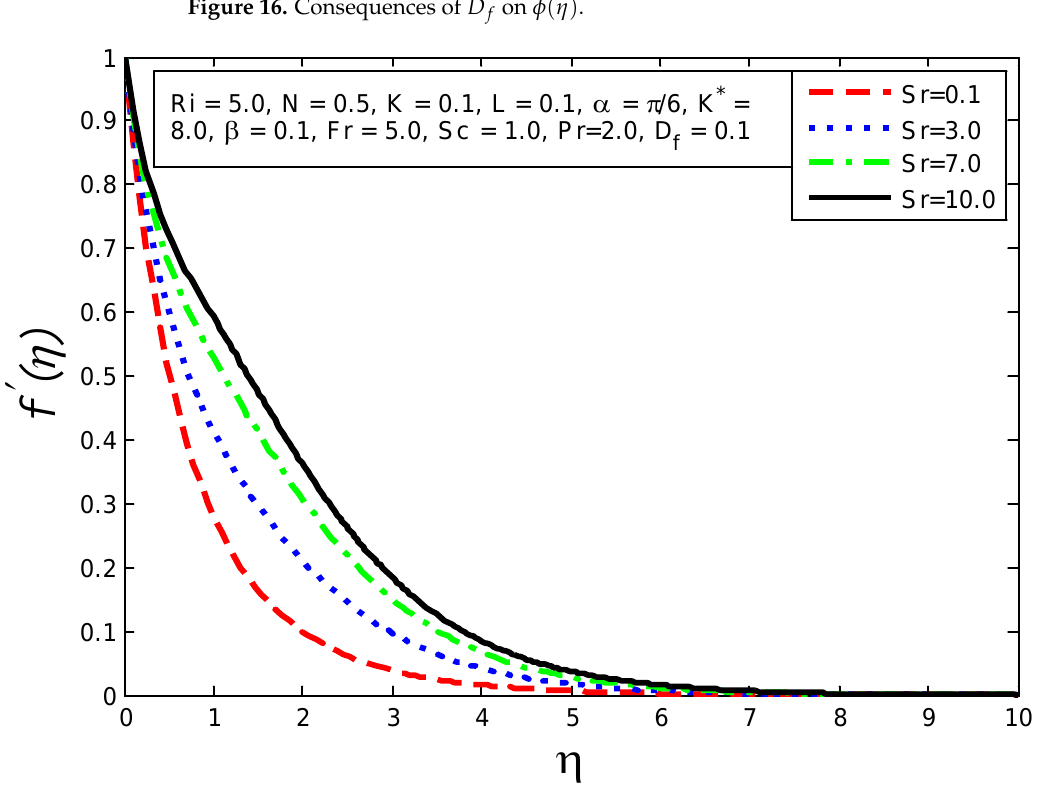
Figure 17. Consequences of Sr on f (cid:48) ( η ) .